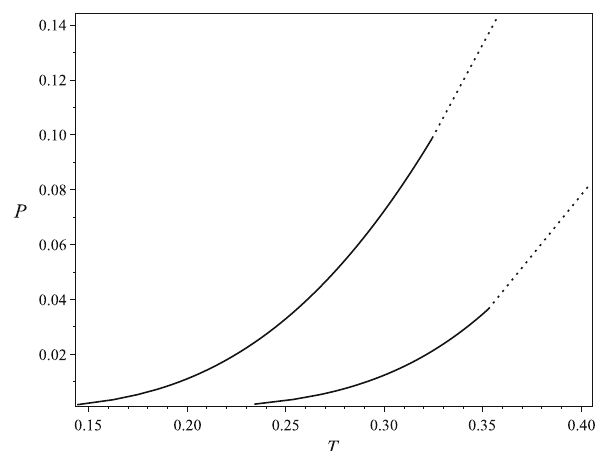
Fig. 8 P – T diagram (coexistence curve) for two phases for n = 3, α = 0 . 5 (the left graph) or α = 0 . 7 (the right one), b = 1, q = 0 . 1. The solid parts of the curves represent the domains where the first order phase transition takes place and the dotted parts of the curves represent the range where the zeroth order phase transition is